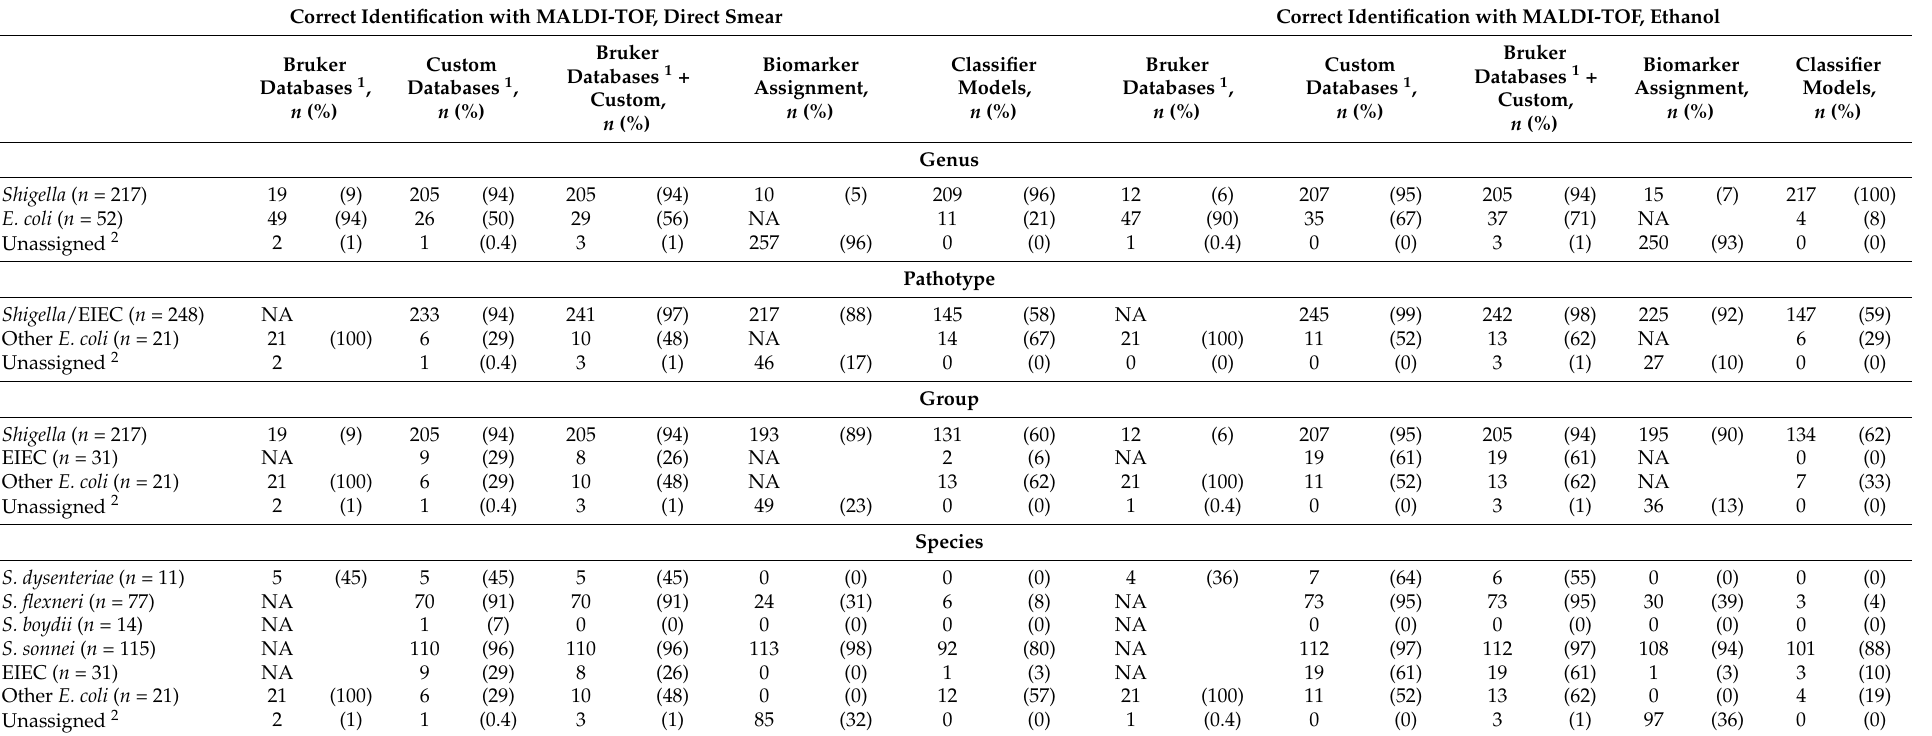
Table 3. Correct identification results of isolates from the test